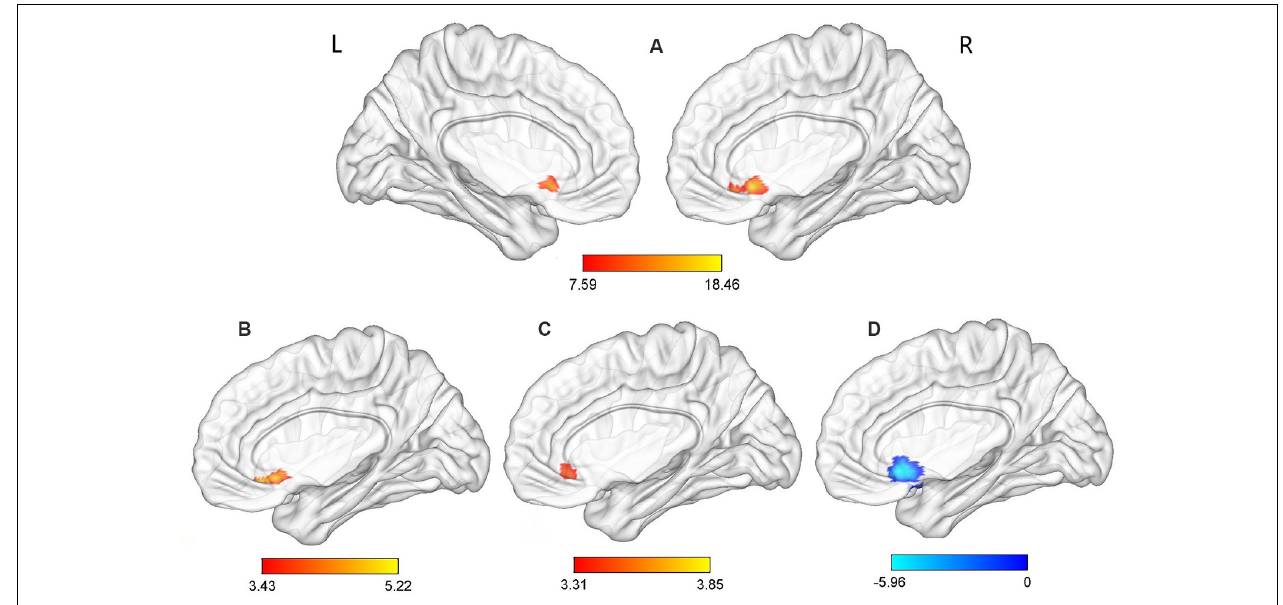
FIGURE 1 | Analysis of variance (ANOVA) and post hoc analysis results for regional homogeneity (ReHo). (A) ANOVA among three groups; (B) comparison between the tremor-dominant Parkinson’s disease with no sleep disorder (TDPD-NSD) and with sleep disorder (TDPD-SD) groups; (C) comparison between the healthy control (HC) and TDPD-SD groups; (D) comparison between the TDPD-NSD and HC groups; color bars indicate the t -score, with warm-colored areas representing brain regions where ReHo/functional connectivity (FC) values increased and cool-colored areas representing brain regions where ReHo/FC values decreased. R, right; L,